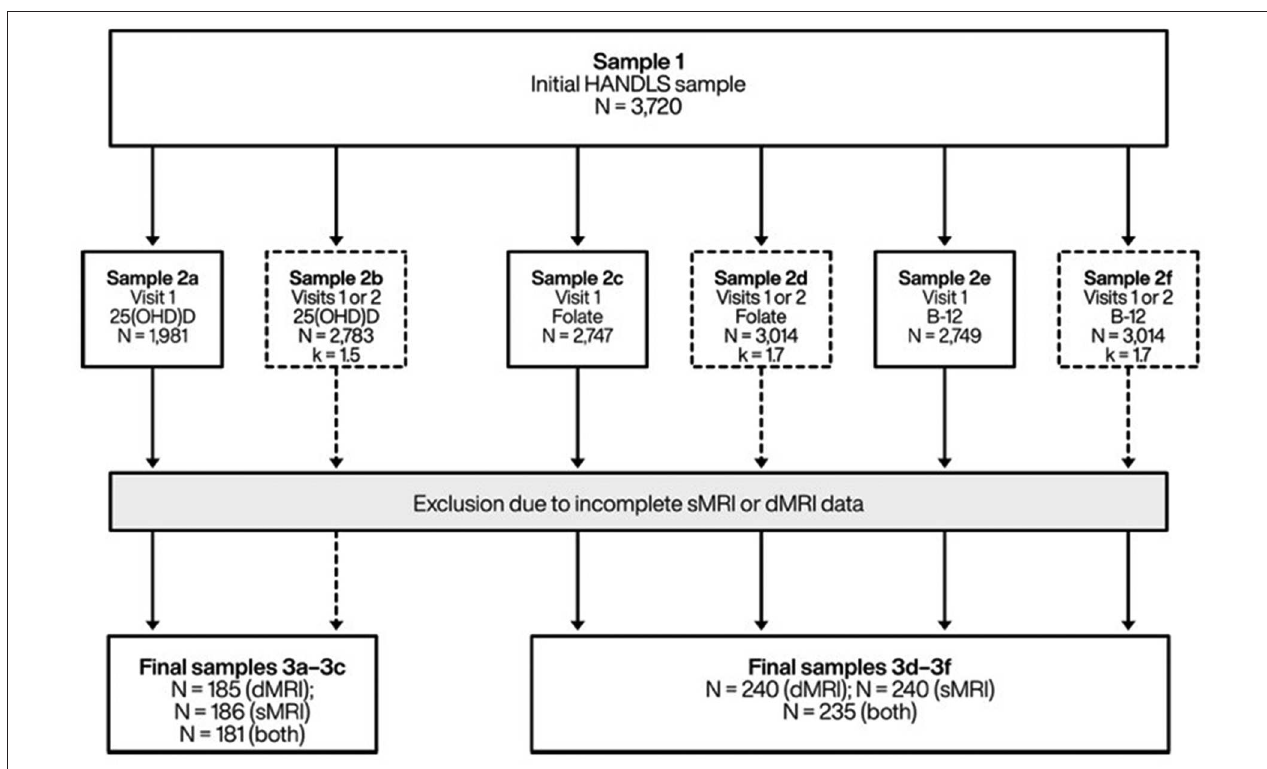
FIGURE 1 | Study participant schematic: HANDLS 2004–2013 and HANDLS-SCAN 2011–2015 a . 25(OH)D, 25-hydroxyvitamin D; B-12, Vitamin B-12 (cobalamin); dMRI, Diffusion magnetic resonance imaging; HANDLS, Healthy Aging in Neighborhoods of Diversity Across the Life Span; k, average number of repeats; sMRI, Structural/volumetric magnetic resonance imaging. a Visit 1 refers to HANDLS 2004–2009; Visit 2 refers to HANDLS 2009–2013; and HANDLS-SCAN visit (v scan ) was carried out between 2011 and